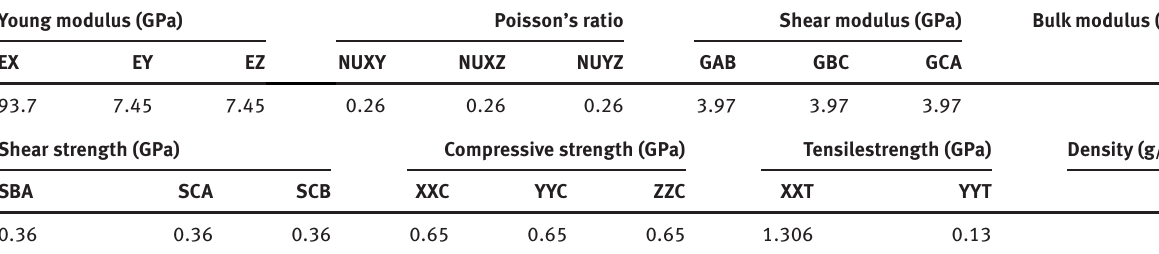
Table 4: Material parameters of sub layer with 0 ply angle Young modulus (GPa)